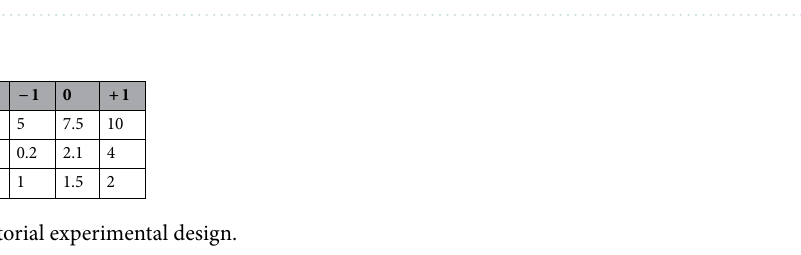
Table 1. Characteristics of rice straw, wheat straw and bagasse 12 .